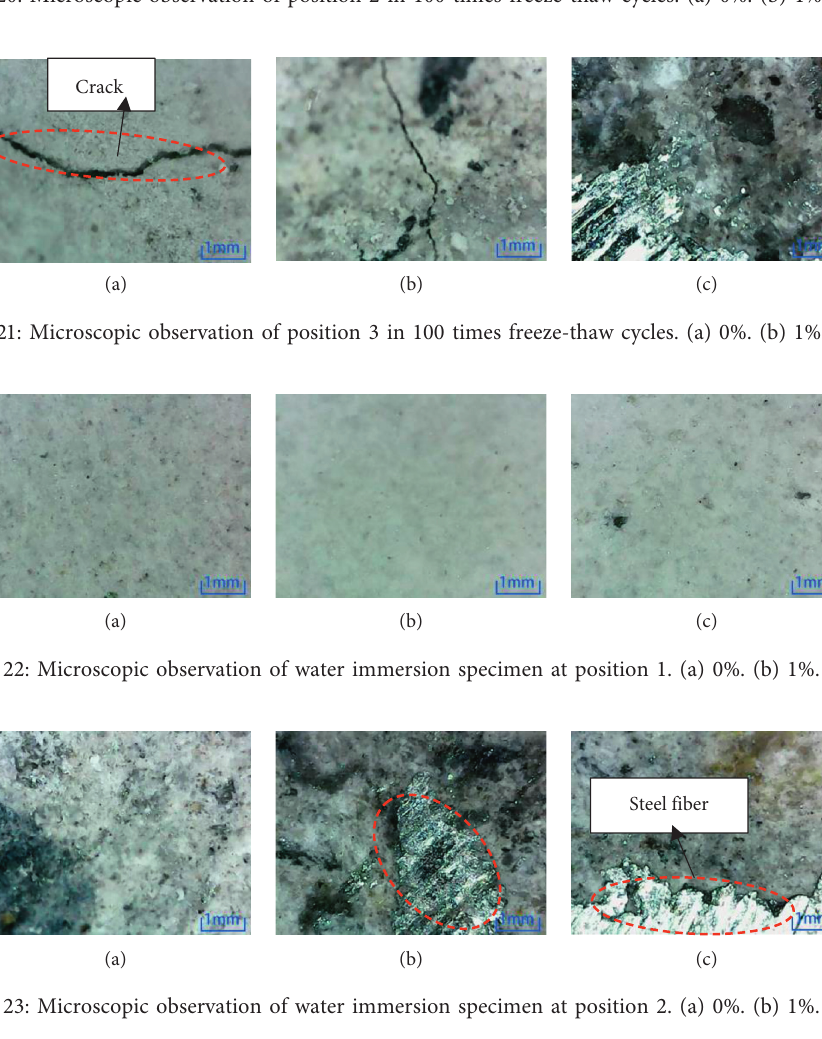
Figure 20: Microscopic observation of position 2 in 100 times freeze-thaw cycles. (a) 0%. (b) 1%. (c) 2%.